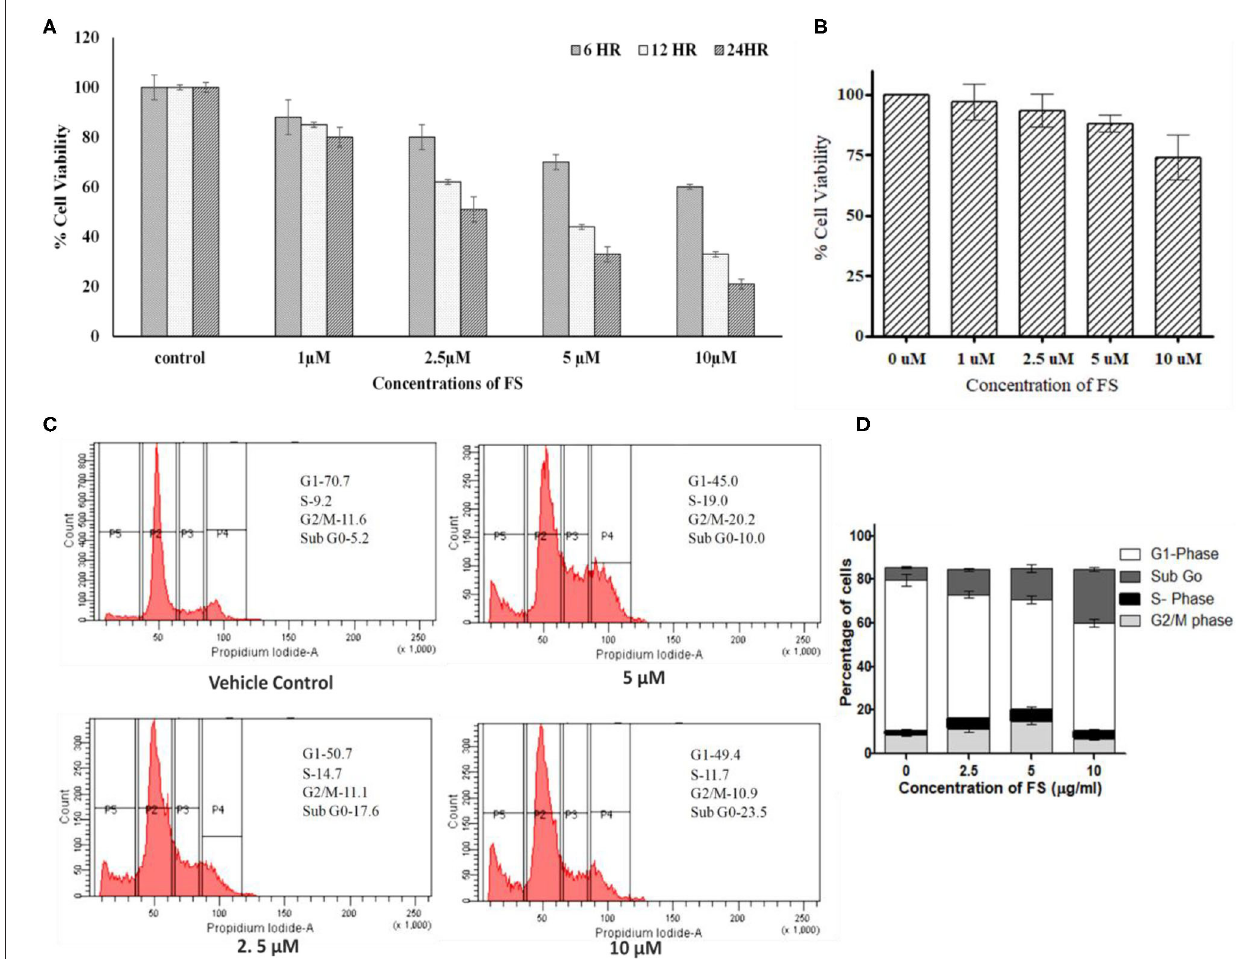
FIGURE 2 | Effect of fungal taxol (FS) on the growth and cell cycle distribution in A549 cells. (A) Effect of FS on cell proliferation. Lung cancer cell line A549 cells were treated with different concentrations (5, 10, and 20 µ M) of FS for 24h. Cell viability was determined by MTT assay at 6, 12, and 24h and expressed as percent of the control value. Dimethyl sulfoxide (DMSO)-treated (0.1%) cells served as vehicle control. Data are the means ± SD of three independent experiments. (B) Normal HEK-293 cells treated with different concentrations (5, 10, and 20 µ M) of FS for 24h remain unaffected. Cell viability was determined by MTT assay at 24h and expressed as percent of the control value. DMSO-treated (0.1%) cells served as vehicle control. Data are the means ± SD of three independent experiments. (C) Effect of FS on cell cycle progression on A549 cells at 6h. The cells were treated with different concentrations of FS (2.5, 5, and 10 µ M) for 24h and subsequently analyzed by flow cytometry using propidium iodide staining to determine the cell cycle. The cell cycle distributions at sub-G0, G1, S, and G2/M phases are represented. The subG0 phase represents cells undergoing apoptosis or cell death. (D) The bar diagram represents the population of cells at different phases of the cell cycle. Data are the means ± SD of three independent